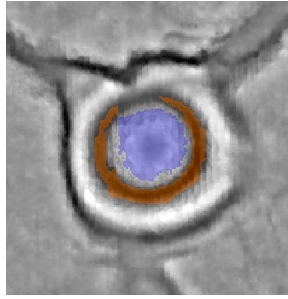
Figure 14 . Detected castle in Paderborn [13]. Figure 14. Detected castle in Paderborn